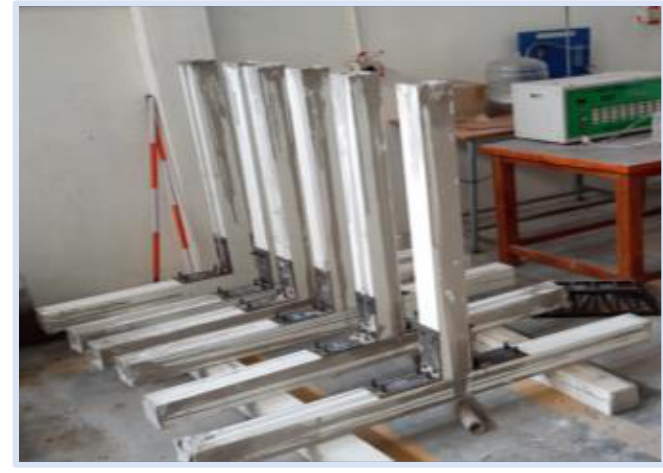
Figure 5. The casting of GFRP beam-column specimens. 2.4. Experimental Investigation Lateral Loading on Pultruded GFRP Beam-Column with and without HVFA-ECC GFRP beam-columns with and without HVFA-ECC infill consist of a 1.5 m long beam and a 1.1 m high column connected using steel angle plates and bolts. A schematic diagram of the experimental setup for beam-columns is shown in Figure 6.